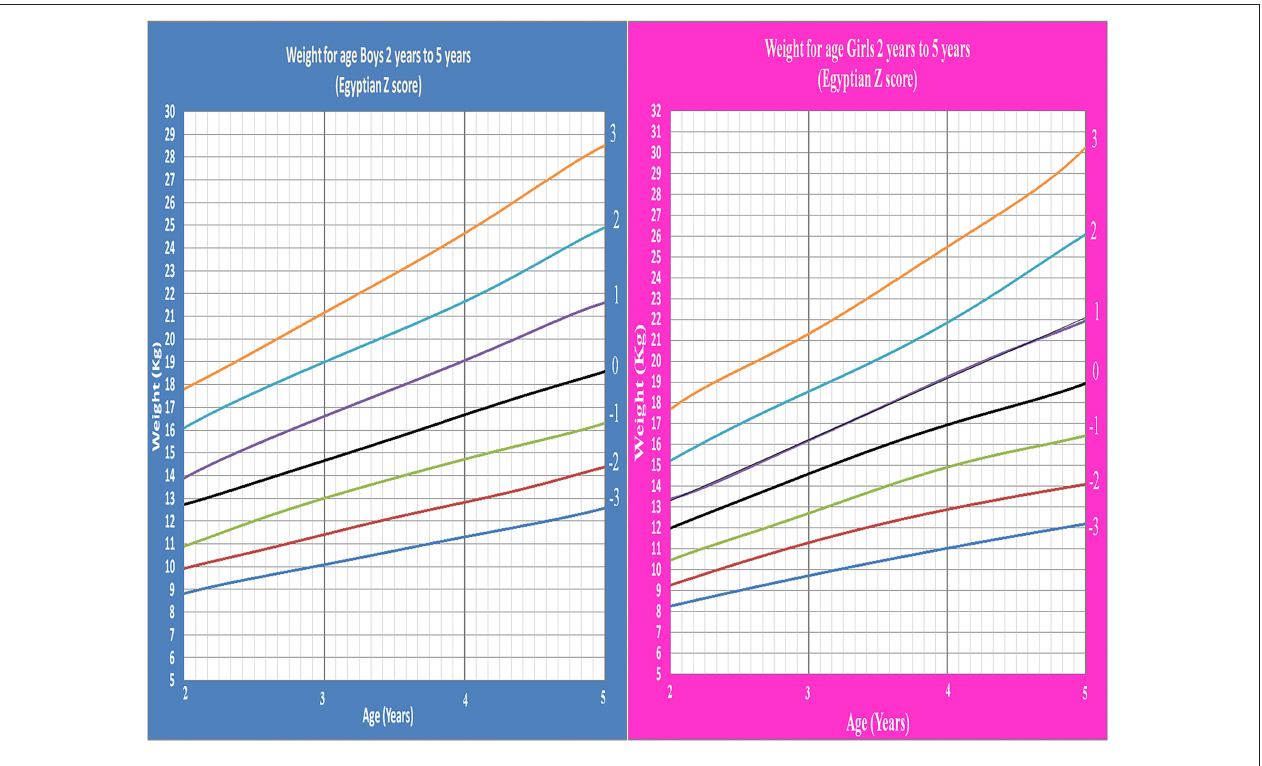
FIGURE 2 | Egyptian Z score weight for age from 2 to 5 years for boys & girls.